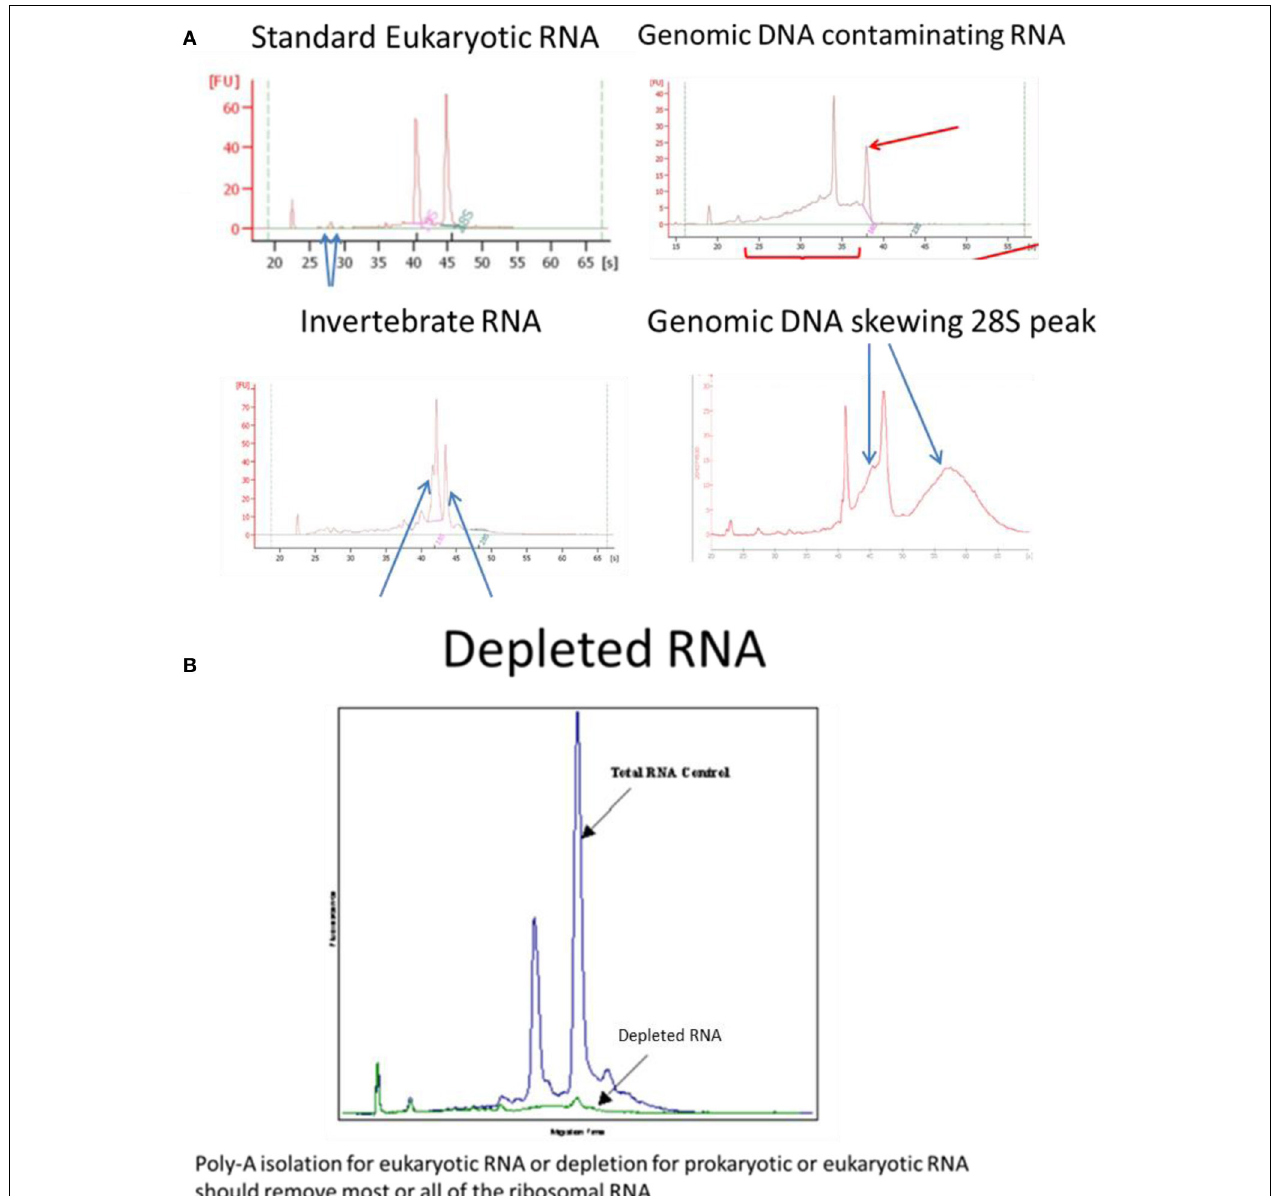
FIGURE 1 | Examples of Bioanalyser assay interpretation for a variety of RNAs. (A) Standard Eukaryotic RNA shows a 28S rRNA band at 4.5kb that should be twice the intensity of the 18S rRNA band at 1.9kb (human) resulting in a RIN = 8.0–10.0. Small peaks are sometimes present after the marker that represent 5S and 5.8S subunits, tRNAs and small RNA fragments about 100bp; these are more obvious when using phenol or trizol exterection methods, QIagen columns will generally remove small RNAs. When degraded 28S RNA is reduced and more fragments are detected